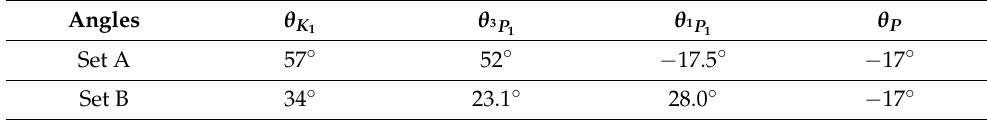
Table 5. Two sets of values of the axial-vector meson mixing angles taken from Ref. [30]. Set B is preferred in Ref. [30]. The η - η (cid:48) mixing angle θ P is taken from Ref. [31]. For more discussions